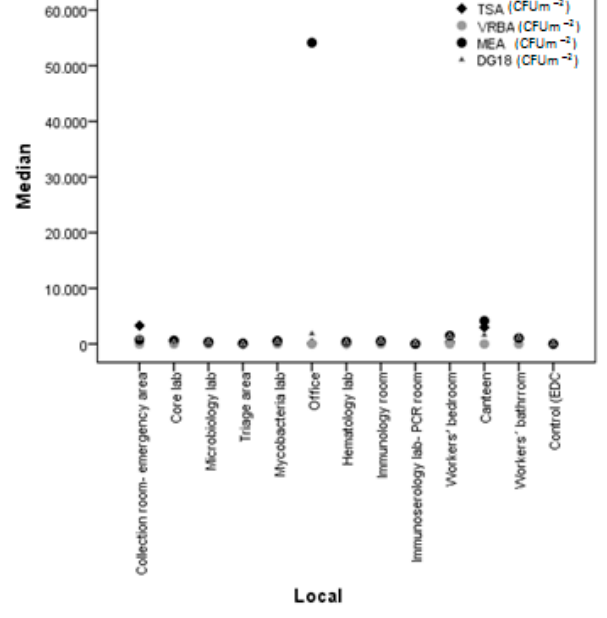
Figure 4. Comparison of fungal and bacterial load between collection sites in